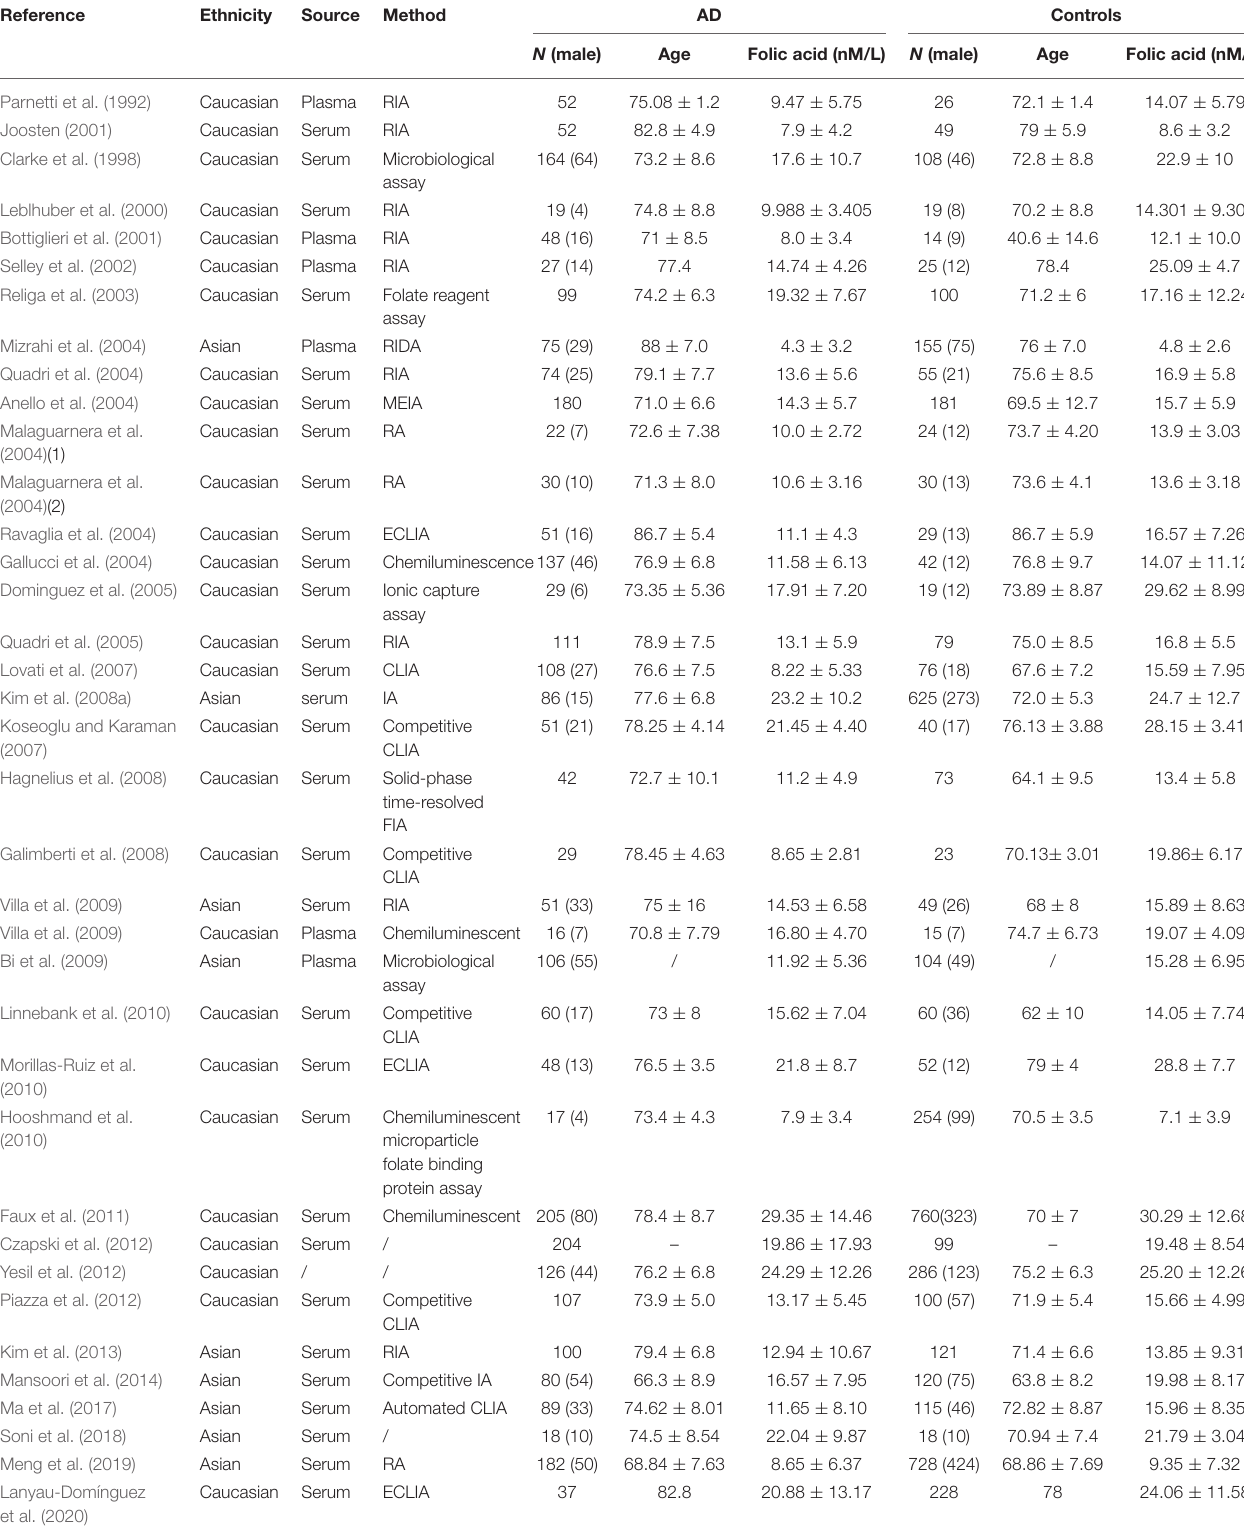
TABLE 2 | The baseline characteristics of included studies (folic